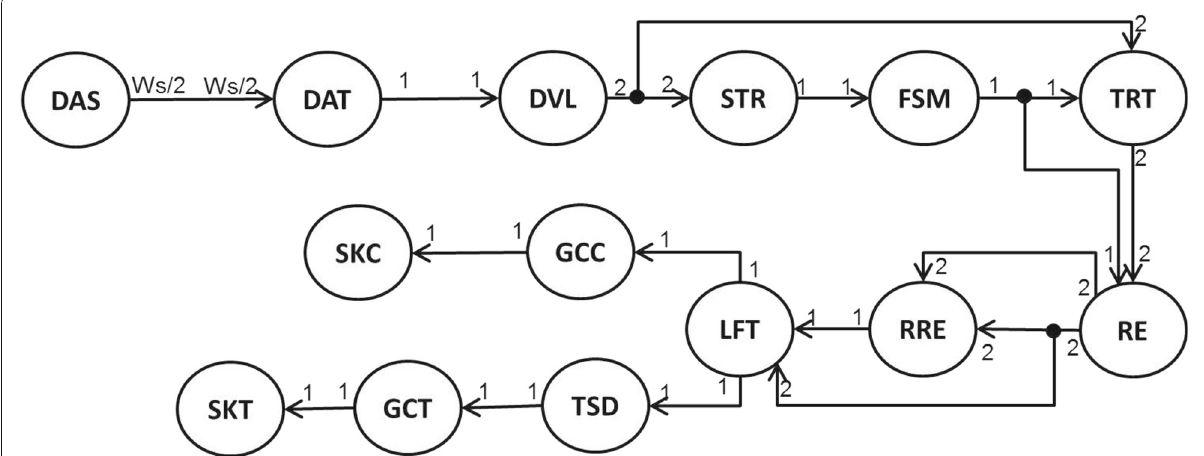
Fig. 2 Dataflow graph for deep jitter measurement